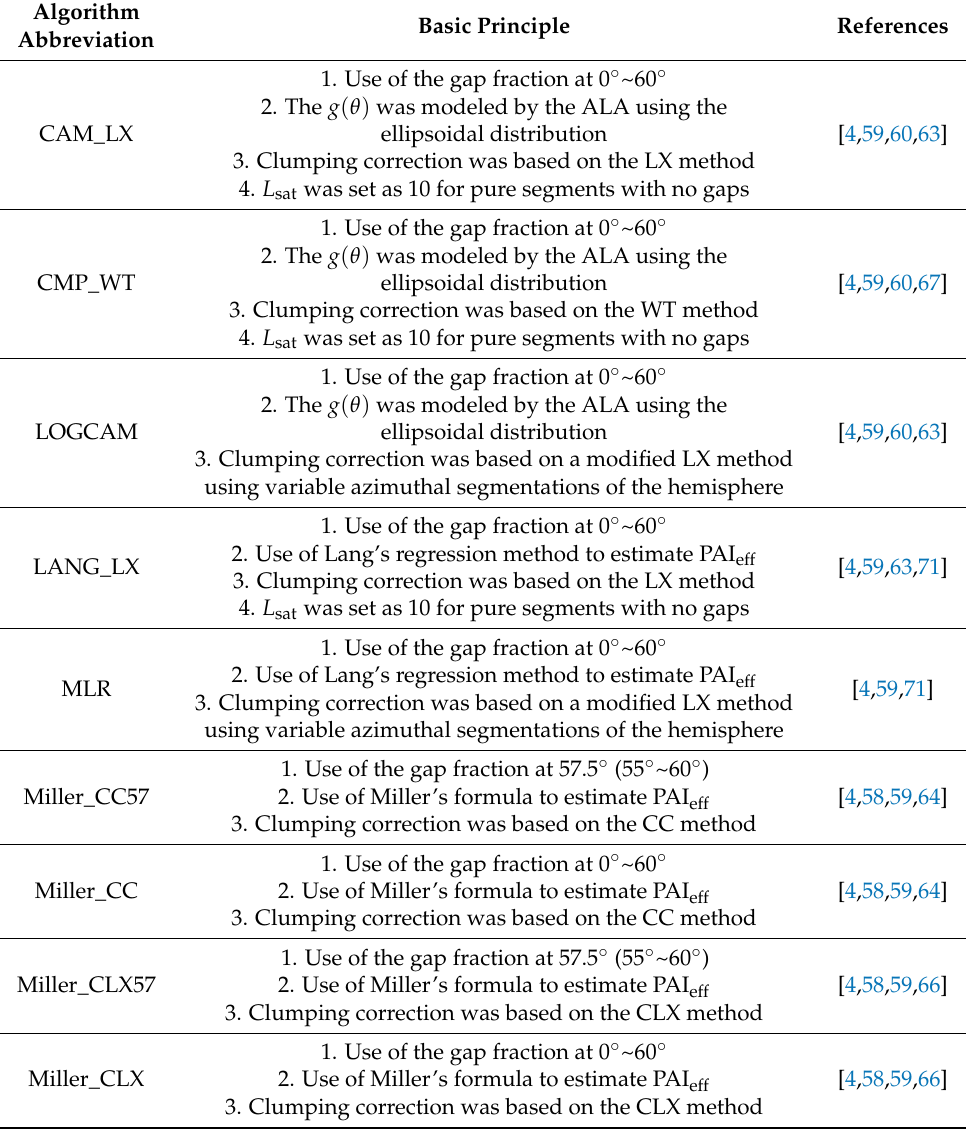
Table 3. PAI true algorithms in the CIMES.